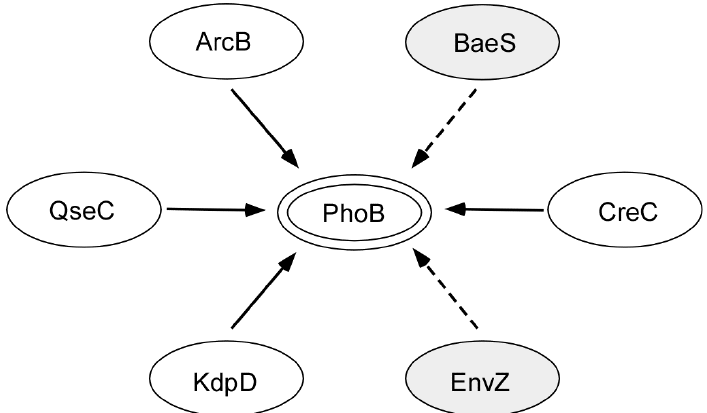
Fig. 1. Activation of PhoB by noncognate HKs. Hollow ovals with thick arrows show HKs that strongly activate PhoB; filled ovals with dashed arrows show HKs that weakly activate PhoB. See